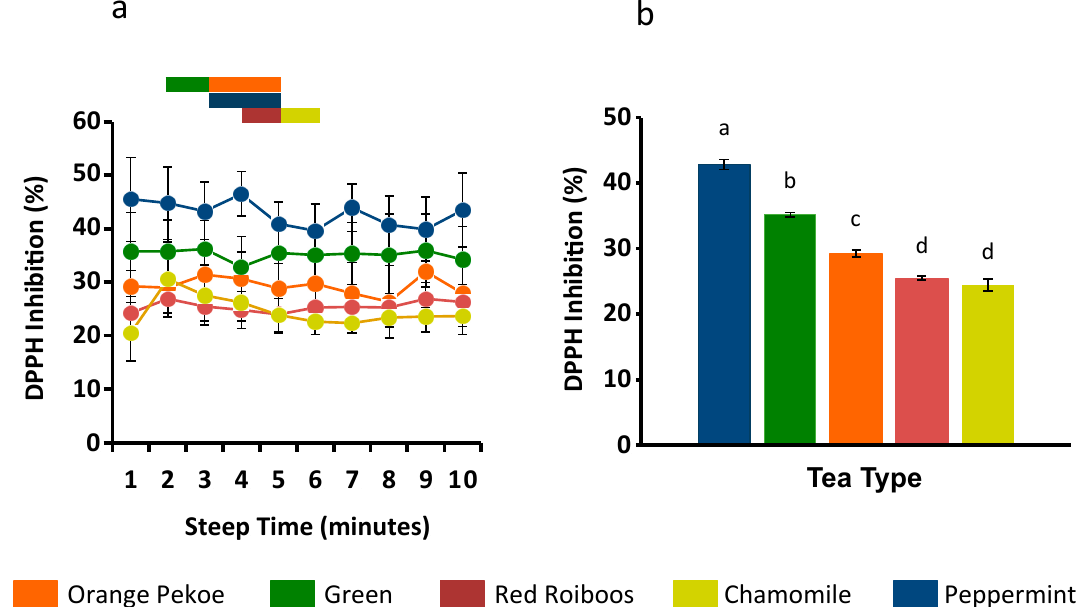
Figure 3. Antioxidant scavenging ability of teas: Orange Pekoe, Green tea, Red Rooibos, Chamomile, and Peppermint over a 10 minute steep time window with minutely extractions. ( a ) normalized amount of tea polyphenols (1 µg GAE/mL) and % of DPPH inhibited through various steep times. Coloured bars indicate the manufacturers suggested steep time for each tea type; ( b ) DPPH inhibition in all tea types with steep times of 1–10 min averaged. A significant difference ( p < 0.05) in percent inhibition of DPPH between tea types is indicated by differing letters.